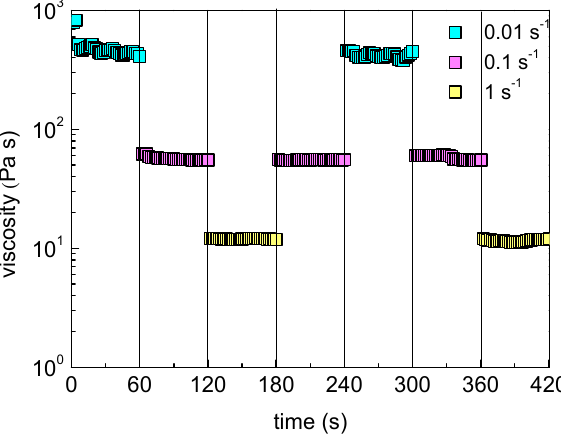
Figure 7. Consecutive shear viscosity time sweep in time intervals of 60 s for the 1 wt% PAA-g-P(boc-LL), pH 8.8 formulation, subjected to stepwise shear rate variations as indicated. To estimate the injectability through a syringe needle for formulations (e.g., C P = 0.5